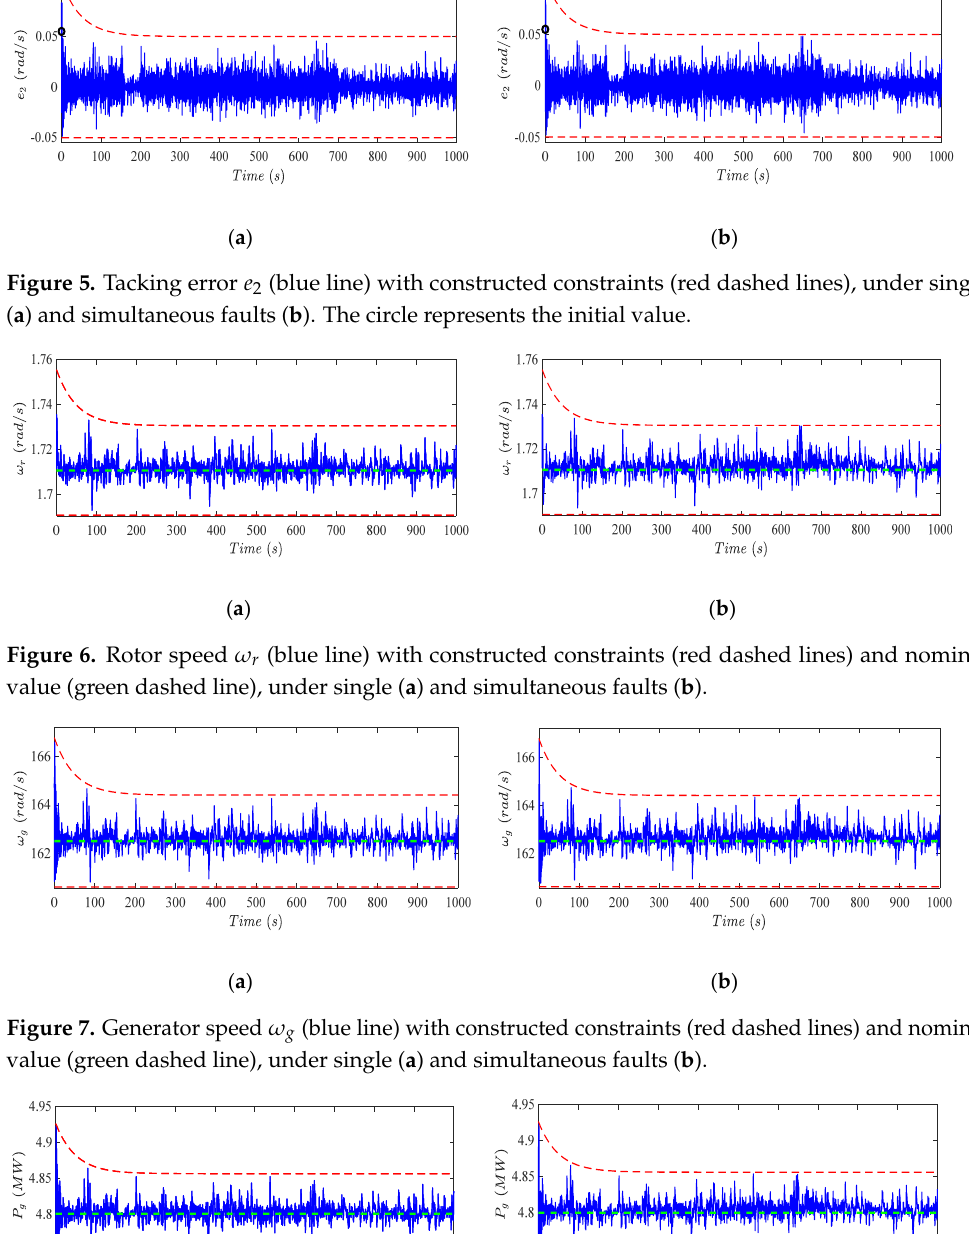
Figure 4. Tacking error 𝑒 (cid:2869) (blue line) with constructed constraints (red dashed lines), under single ( a ) and simultaneous faults ( b ). The circle represents the initial value.